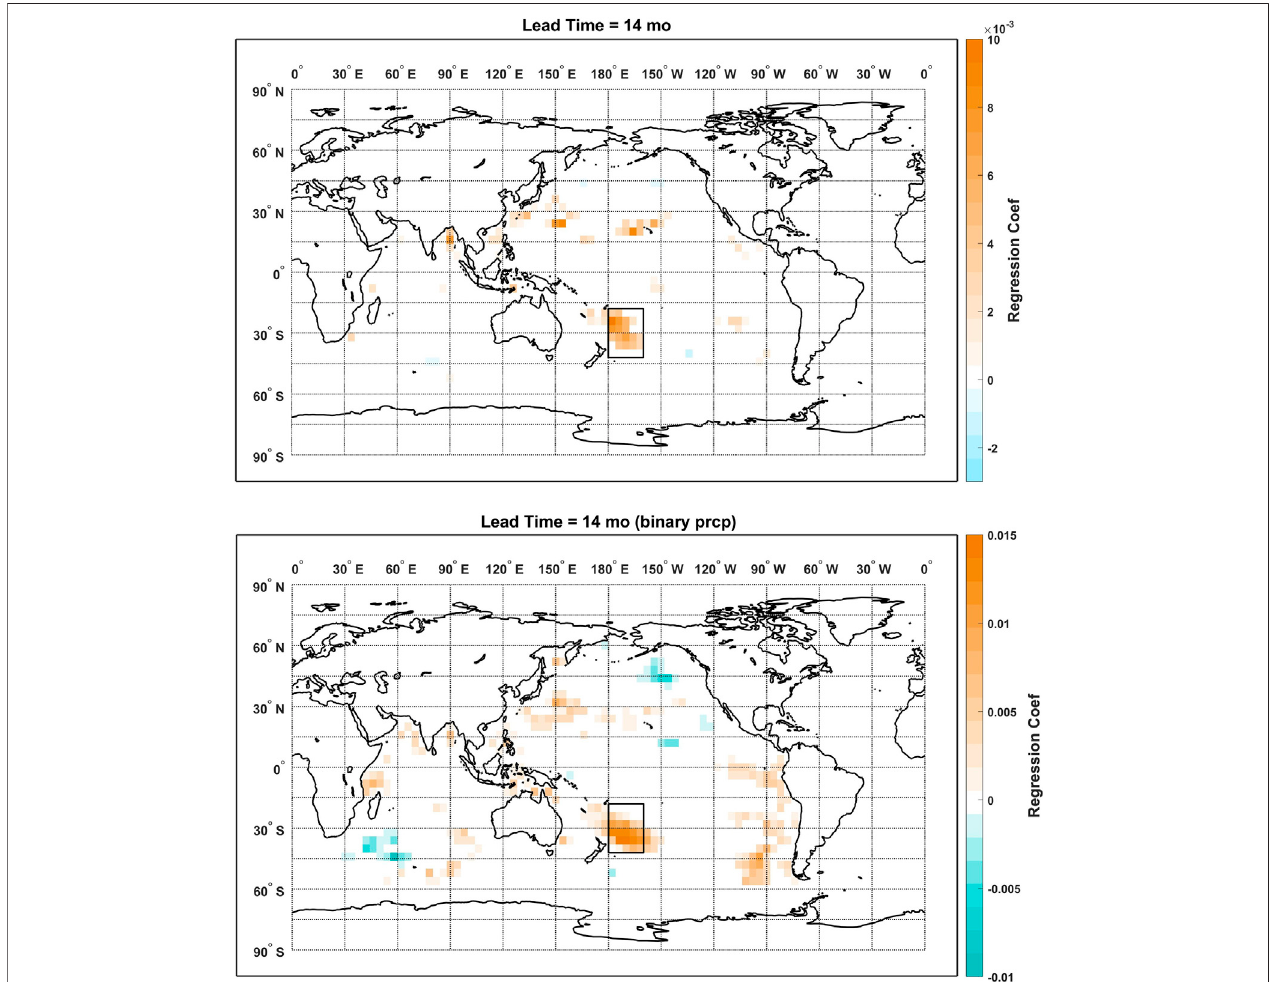
FIGURE10| Mapsofregressioncoef fi cientsfromtheelasticnetmodelsusingtrue-amplitude (top) andbinary (bottom) predictandprecipitationattheleadtimeof 14 months.